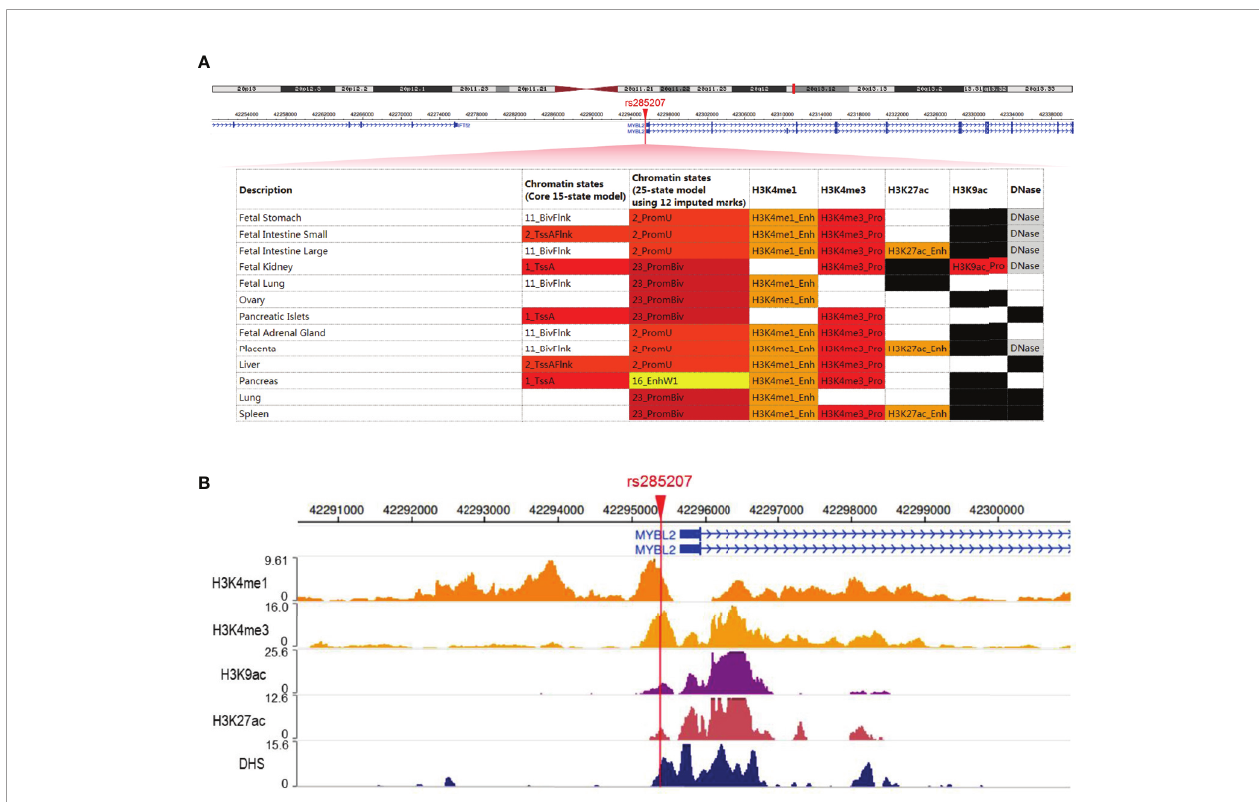
FIGURE 1 | rs285207 overlapped both promoter and enhancer of MYBL2 gene (A) Schematic of rs285207 region with histone and DHS mark annotations in different tissue types in the Roadmap epigenomics data. (B) H3K4me1, H3K4me3, H3K9ac, H3K27ac and DHS ChIP-seq signals at the rs285207 locus in GM12878